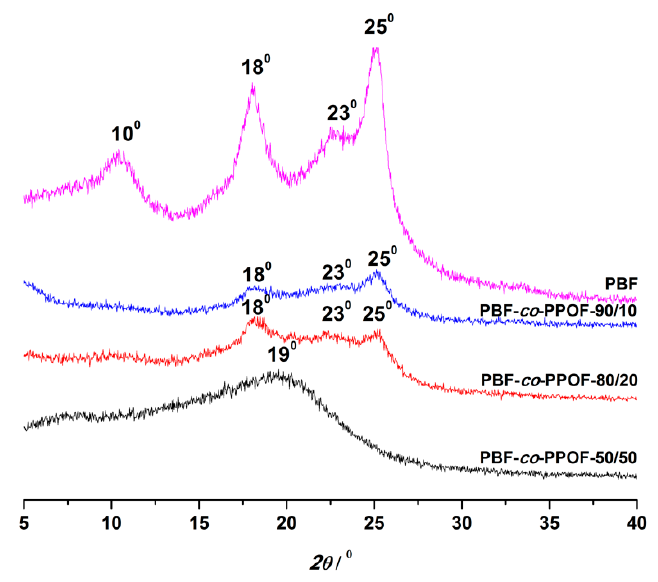
Figure 3. XRD patterns of PBF and all PBF- co -PPOF materials.